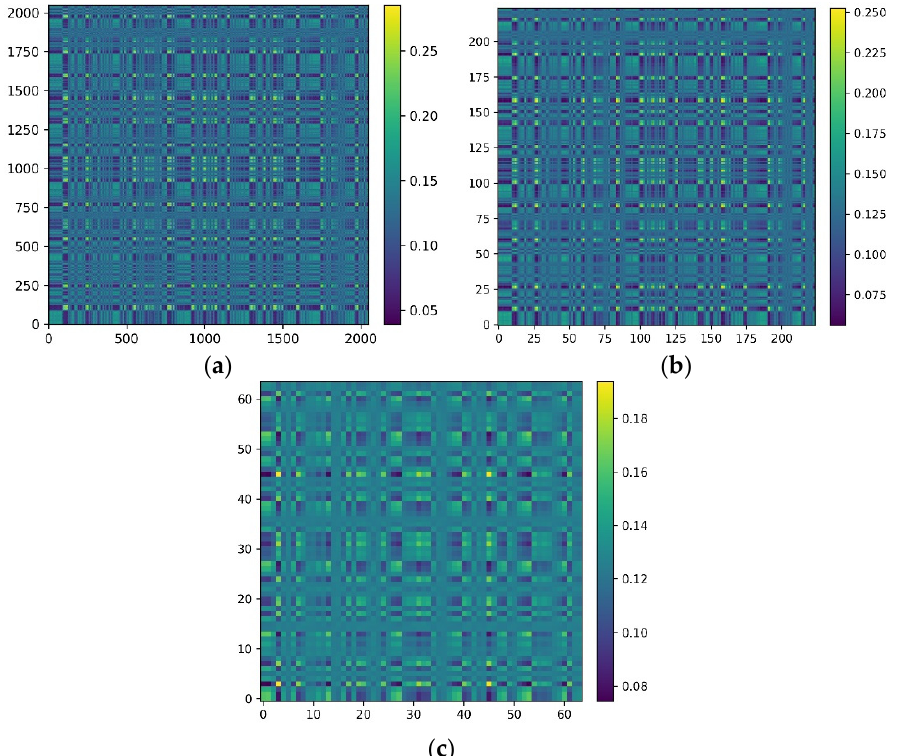
Figure 6. Transformation of the same signal containing 2048 data points into MTF images of image sizes of ( a ) 2048 × 2048, ( b ) 224 × 224, and ( c ) 64 ×